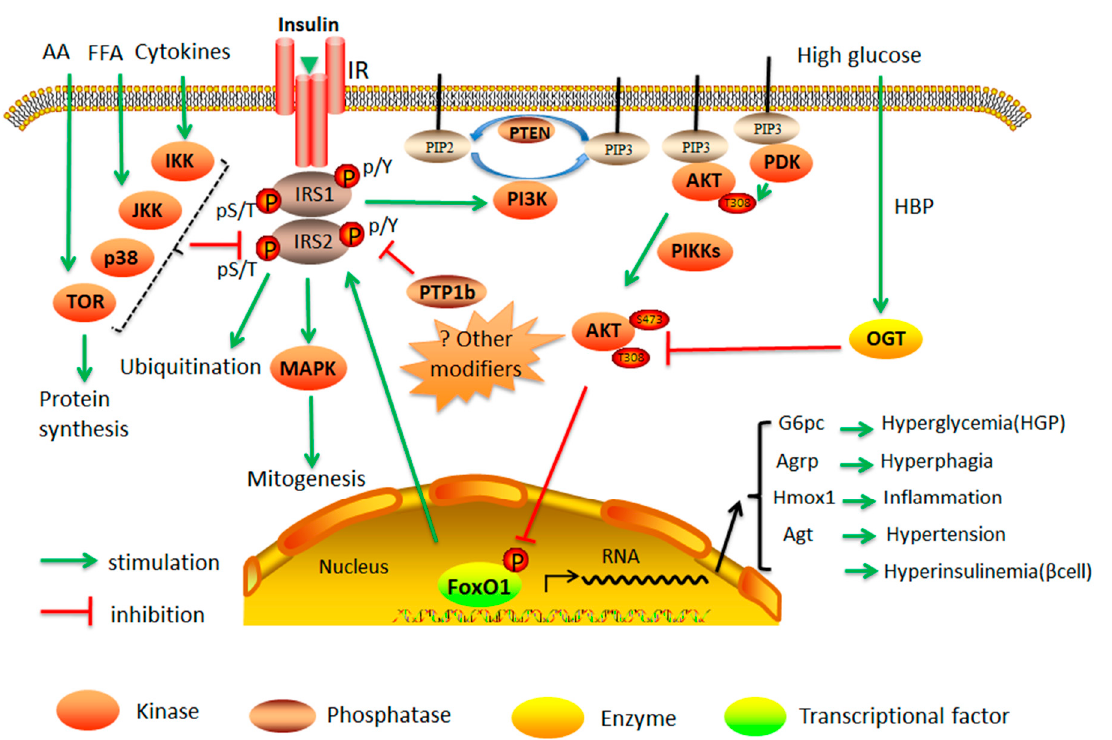
Figure 1. The role of kinases in the insulin signaling cascades and its interaction with nutrients in control of FOXO1-mediated physiological function. AA—amino acids; FFA—free fatty acids; HGP—hepatic glucose